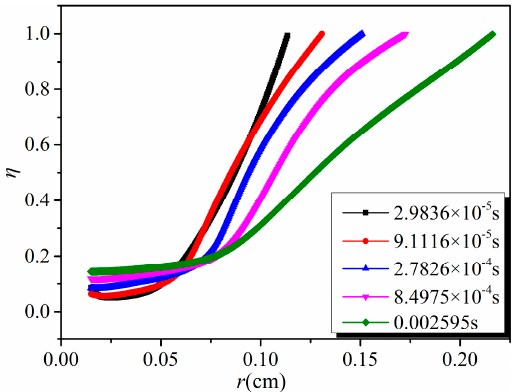
Figure 11. Distribution of η in the effective removal area of NO at various time steps.